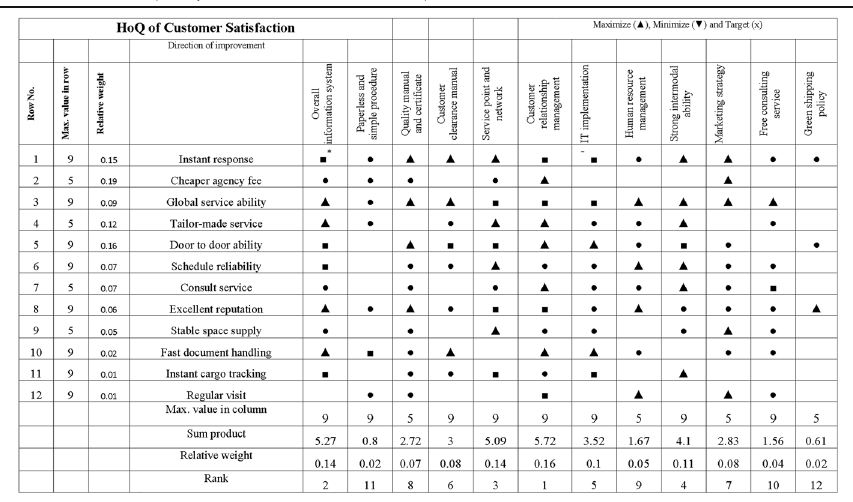
Table 5 House of quality matrix for customer requirements and technical